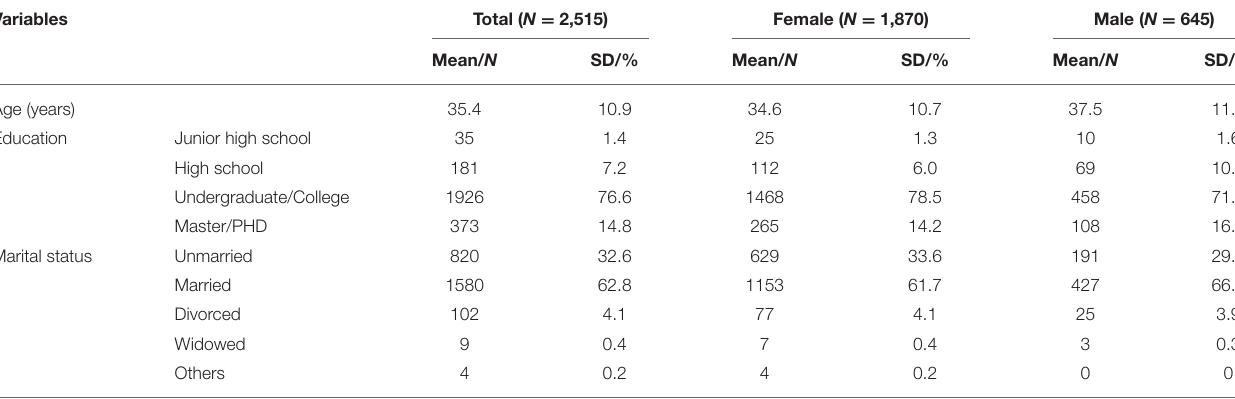
TABLE 1 | The socio-demographic information of all included samples. Variables